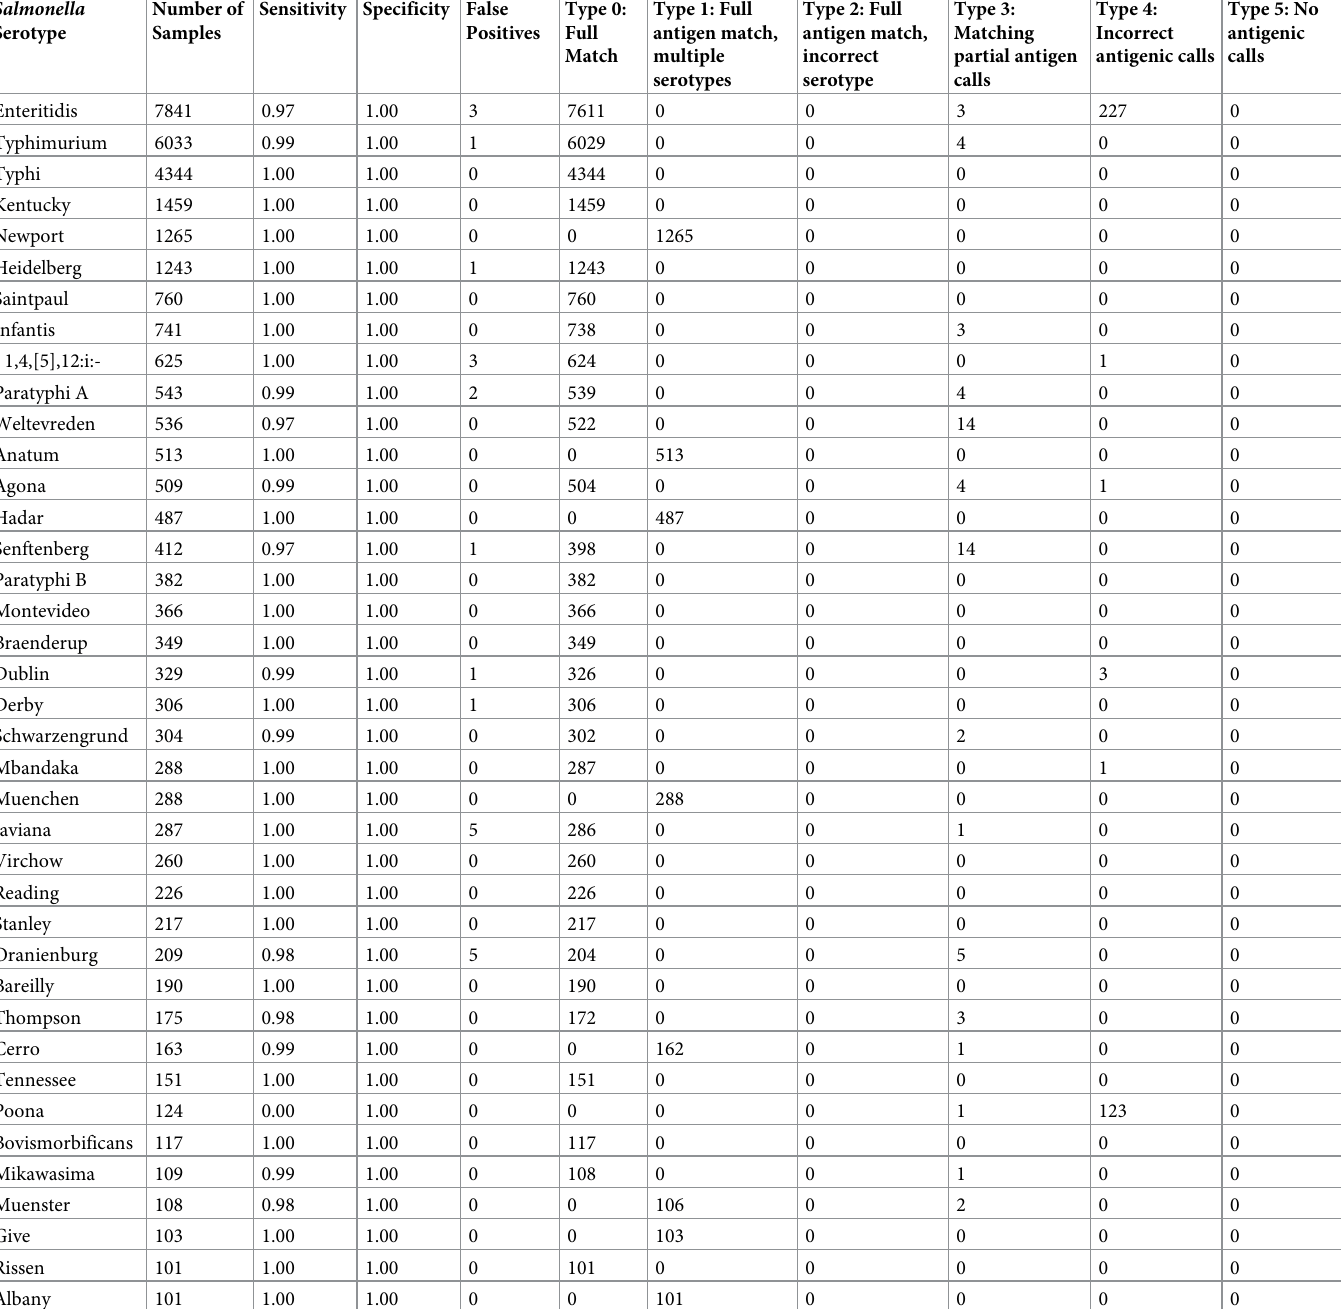
Table 2. In silico performance of the SGSA v. 2 classifications based on simulated probe intensities for serotypes with at least 100 samples tested. Records were assigned to five different categories as described in the materials and methods. Salmonella